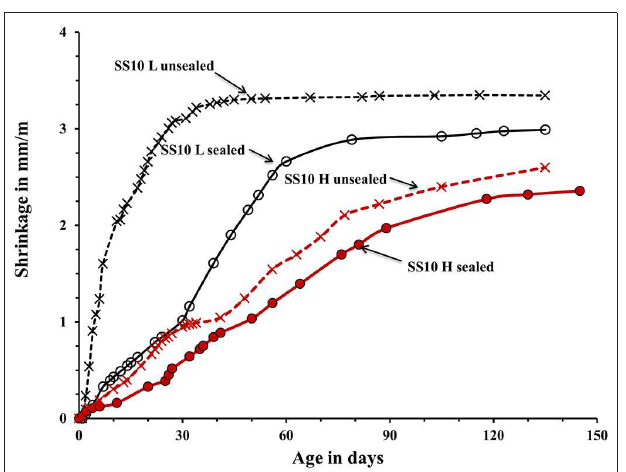
FIGURE 6 | Shrinkage of the laboratory- and heat-cured AAS concrete samples activated by 10% sodium silicate SS.